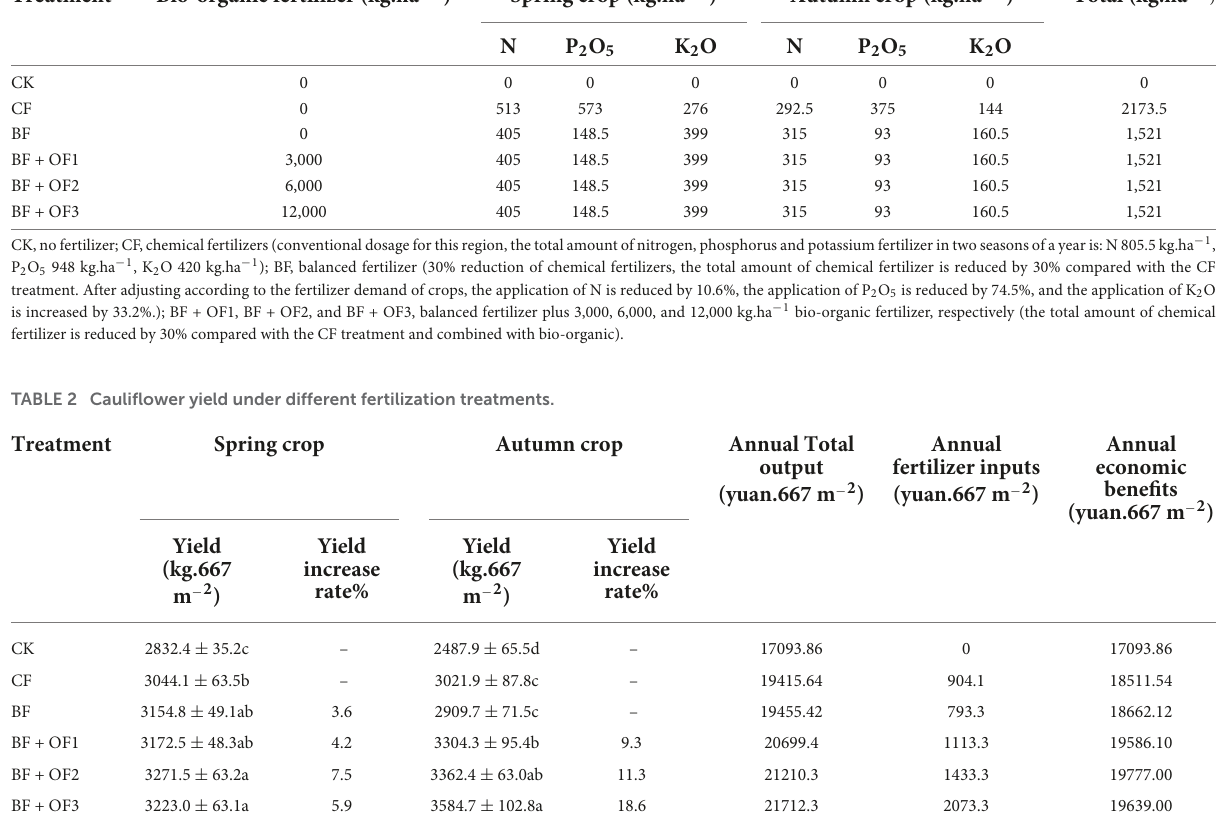
TABLE 1 Fertilizer amounts for different treatments. Treatment Bio-organic fertilizer (kg.ha − 1 )